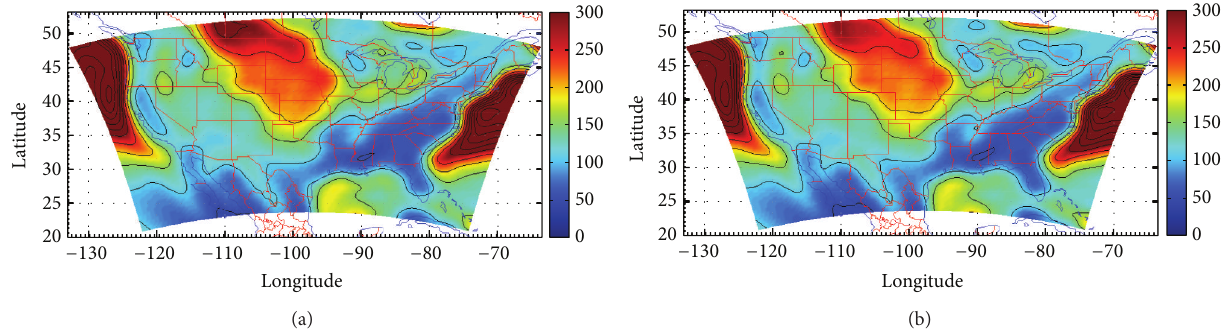
Figure 5: Average annual wind power density (Wm −2 ) from CCSM3 data for (a) 2040s and (b) 2090s under the A1B climate scenario.